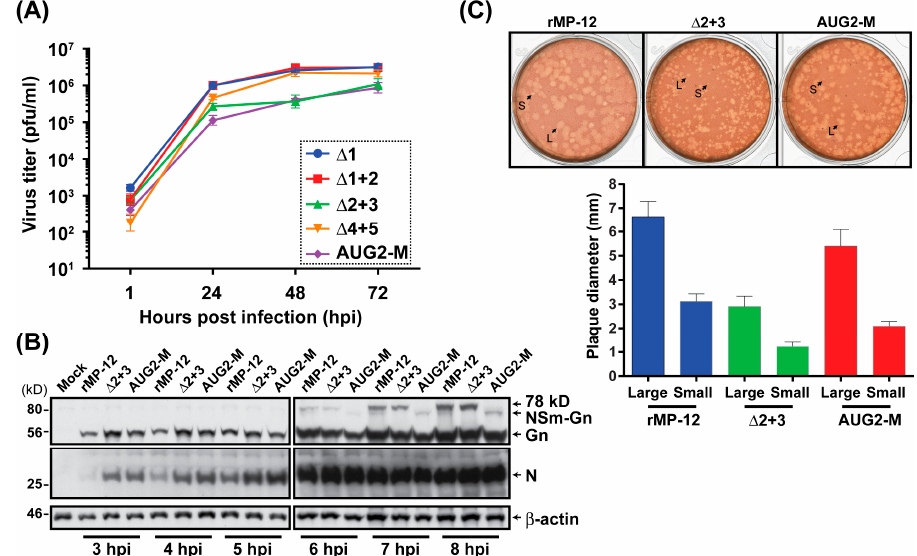
Figure 4. Characterization of recombinant MP-12 encoding mutations in the pre-Gn region. ( A ) Replication of rMP-12 mutants encoding the mutations either in the 1st AUG ( Δ 1), the 1st and 2nd AUG ( Δ 1 + 2), the 2nd and 3rd AUG ( Δ 2 + 3), the 4th and 5th AUG ( Δ 4 + 5), or the deletion of the UTR upstream of the 2nd AUG (AUG2-M: see Figure 3A). Vero cells were infected with each virus at a multiplicity of infection (MOI) of 0.15. The graph represents the antilog of the arithmetic mean of the log 10 -transformed virus titers + the standard deviation of three independent experiments; ( B ) Western blot using Vero cells infected with either rMP-12, Δ 2 + 3, or the AUG2-M mutants (an MOI of 1). The 78 kD and Gn were detected by mouse anti-Gn monoclonal antibody (4D4). The N proteins were detected using mouse anti-RVFV polyclonal antibody. β -actin is shown as sample loading controls; ( C ) plaque phenotypes of rMP-12, Δ 2 + 3, or the AUG2-M mutants in VeroE6 cells. Small (S) and large (L) plaques are shown with arrows. The diameters (mm) of small and large plaques were measured ( n = 10 per sample), and the average and standard errors are shown in the graph.